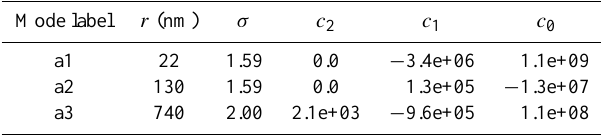
Table 1. Modal radii ( r ) and geometric standard deviations ( σ ) for the three log-normal sea salt modes employed in CAM-Oslo. The three coefficients ( c 2 , c 1 and c 0 ) describe the dependence of the modal number emission flux as a function of the sea